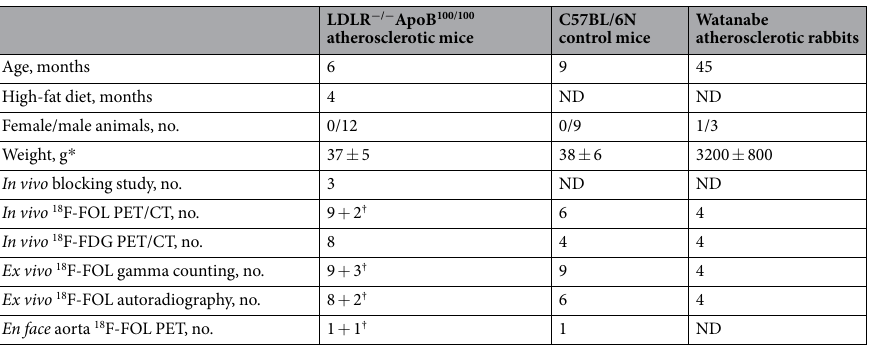
C57BL/6N control mice